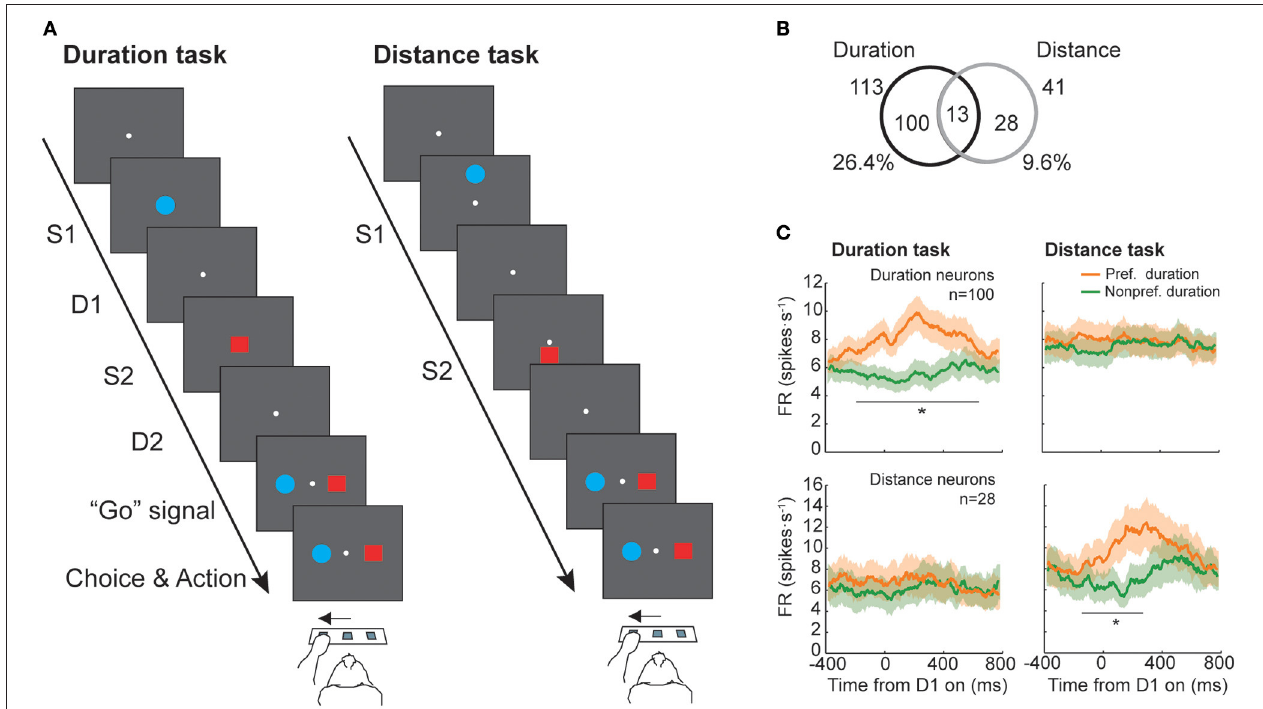
FIGURE 2 | Duration and distance discrimination tasks (adapted from Marcos et al., 2017). (A) Temporal sequence of event during a trial. Each trial started with a pre-stimulus period in which monkeys were required to press and hold the central switch of the infrared array and was followed by the presentation of the first stimulus (S1). A delay period (D1) separated S1 offset from the presentation of the second stimulus (S2). After S1 offset, a second delay period (D2) preceded the reappearance of the two stimuli (targets), acting as “Go” signal, instructing the monkeys to choose the target that had either lasted longer, in the duration task, or had appeared farther from the central reference point, in the distance task. (B) Number of neurons with duration-related activity ( n = 100), distance-related activity ( n = 28) or duration- and distance-related activity ( n = 13). (C) Mean firing rate for preferred and non-preferred conditions of the population of neurons previously classified as having duration- (Top panels) or distance-related (Bottom panels) modulation during the duration (Left panel) and distance (Right panel) tasks (* p < 0.05/24, paired-sample t -test with Bonferroni